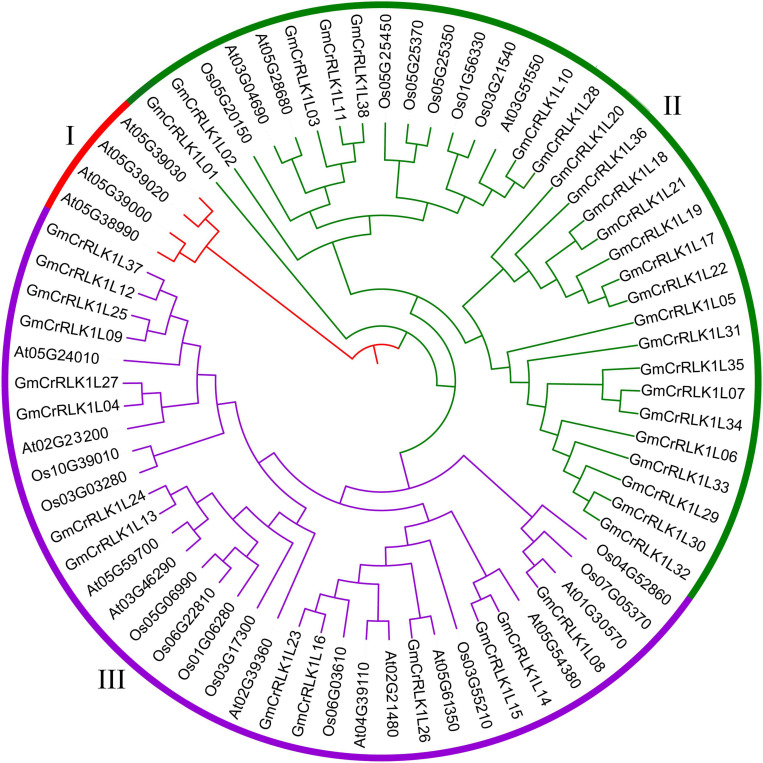
Phylogenetic tree analysis of CrRLK1L genes. The full-length amino acid sequence of the CrRLK1L protein from Arabidopsis, rice, and soybean were aligned by Crustal W and constructed by the NJ (Neighbor-joining) method with 1,000 bootstrap replicates. Distinct subfamilies are marked by different colors.